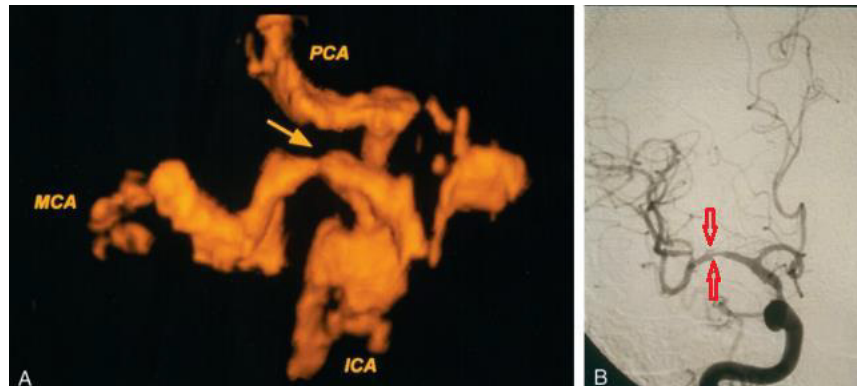
Figure 4 - Anteroposterior images of an intracranial stenosis. A. A 3D power doppler image shows the circle of Willis with severe stenosis (arrow) in the MCA. ICA=internal carotid artery; MCA=middle cerebral artery; PCA=posterior cerebral artery. B. An angiogram confirmed severe stenosis (arrows) in the MCA